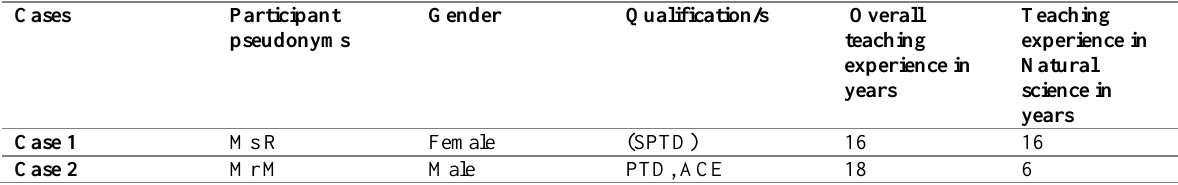
Table 1: Teacher’s qualifications and